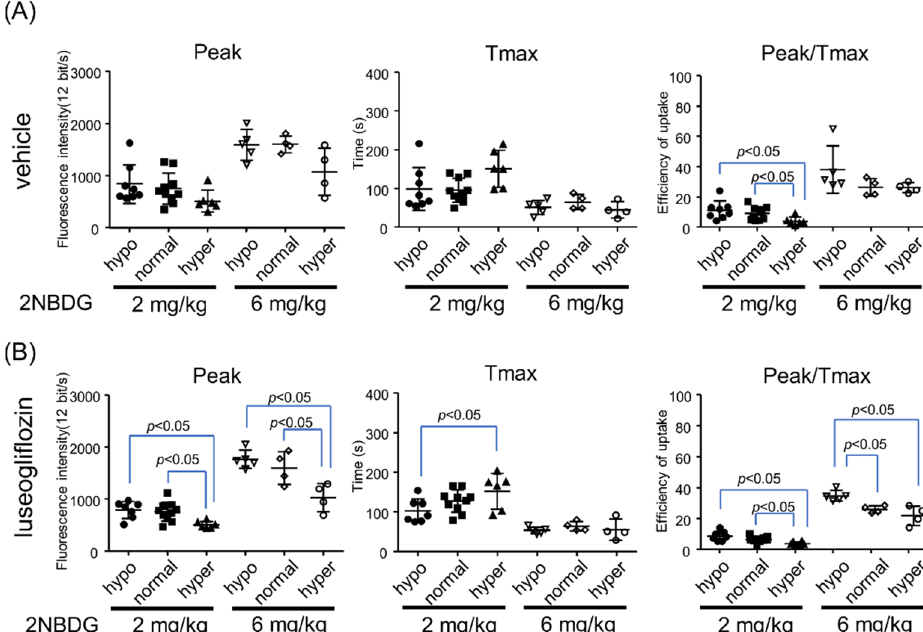
Figure 4. Effects of blood glucose level on 2-NBDG (2 or 6 mg/kg) dynamics in early segments of proximal tubules. Peak, Tmax, and peak/Tmax were compared in ( A ) vehicle- and ( B ) luseogliflozin-treated groups. Hypo: hypoglycemia, normal: normoglycemia, hyper: hyperglycemia. Each dot represents an average value from five proximal tubule cells in each mouse ( n = 7–10 for the 2 mg/kg group and n = 4 for the 6 mg/kg group).